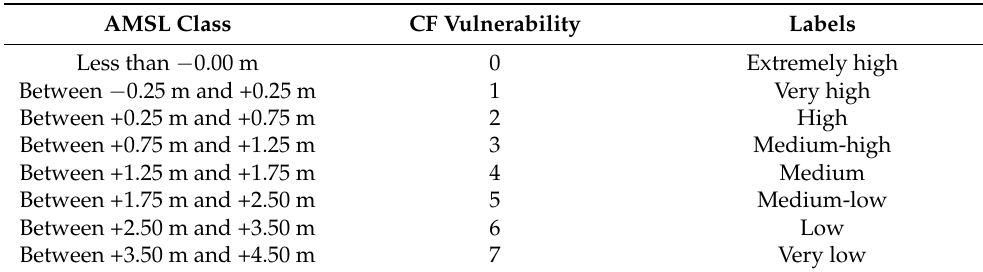
Table 3. CF Vulnerability classes by height Above Mean Sea Level of the DTM. AMSL Class CF Vulnerability Labels Less than − 0.00 m 0 Extremely high Between − 0.25 m and +0.25 m 1 Very high Between +0.25 m and +0.75 m 2 High Between +0.75 m and +1.25 m 3 Medium-high Between +1.25 m and +1.75 m 4 Medium Between +1.75 m and +2.50 m 5 Medium-low Between +2.50 m and +3.50 m 6 Low Between +3.50 m and +4.50 m 7 Very